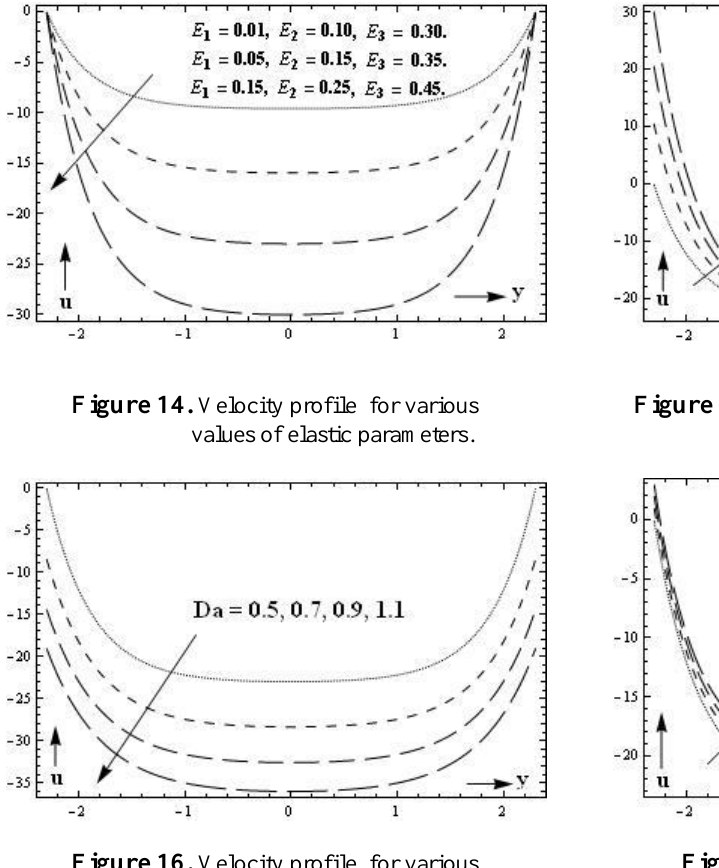
Figure 16. Velocity profile for various values of Darcy number.